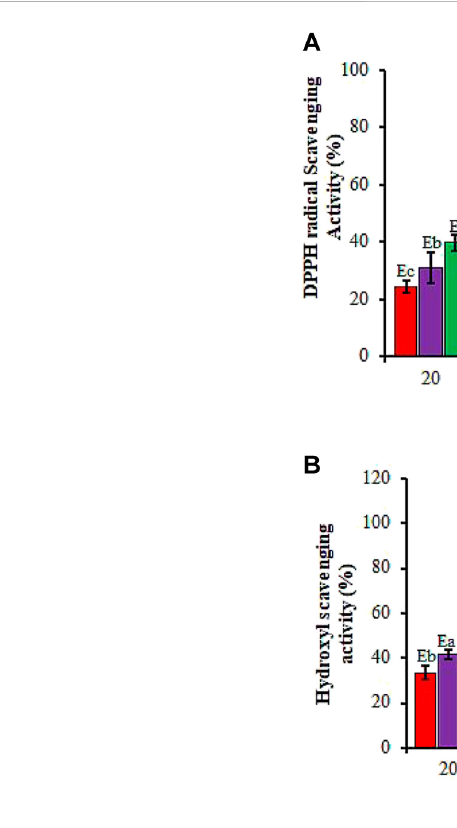
FIGURE 11 The antioxidant activity of RLE and Rn-AgNPs measured using DPPH radical scavenging (a) and hydroxyl scavenging assays. AA, Ascorbic acid. Different lower-case letters denote signi fi cant differences ( p ≤ 0.05) among ascorbic acid, AgNPs and RLE at a particular concentration. Whereas uppercase letters denote signi fi cant differences across different concentrations for a particular